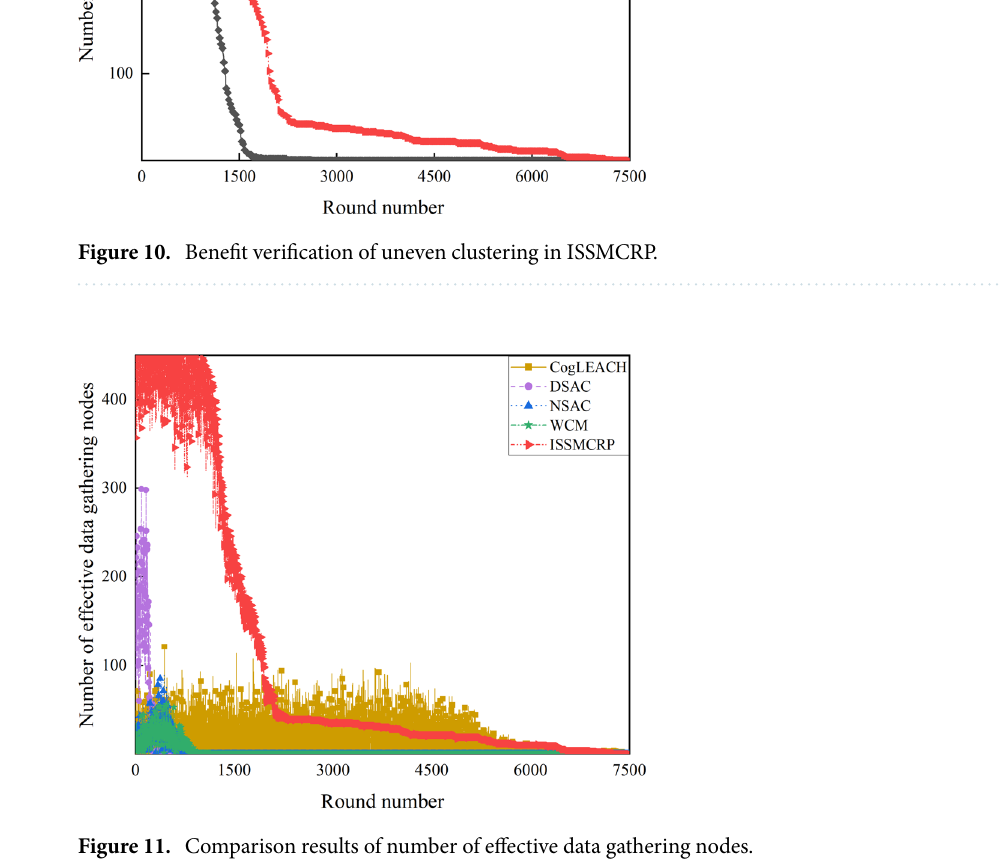
Figure 11. Comparison results of number of effective data gathering